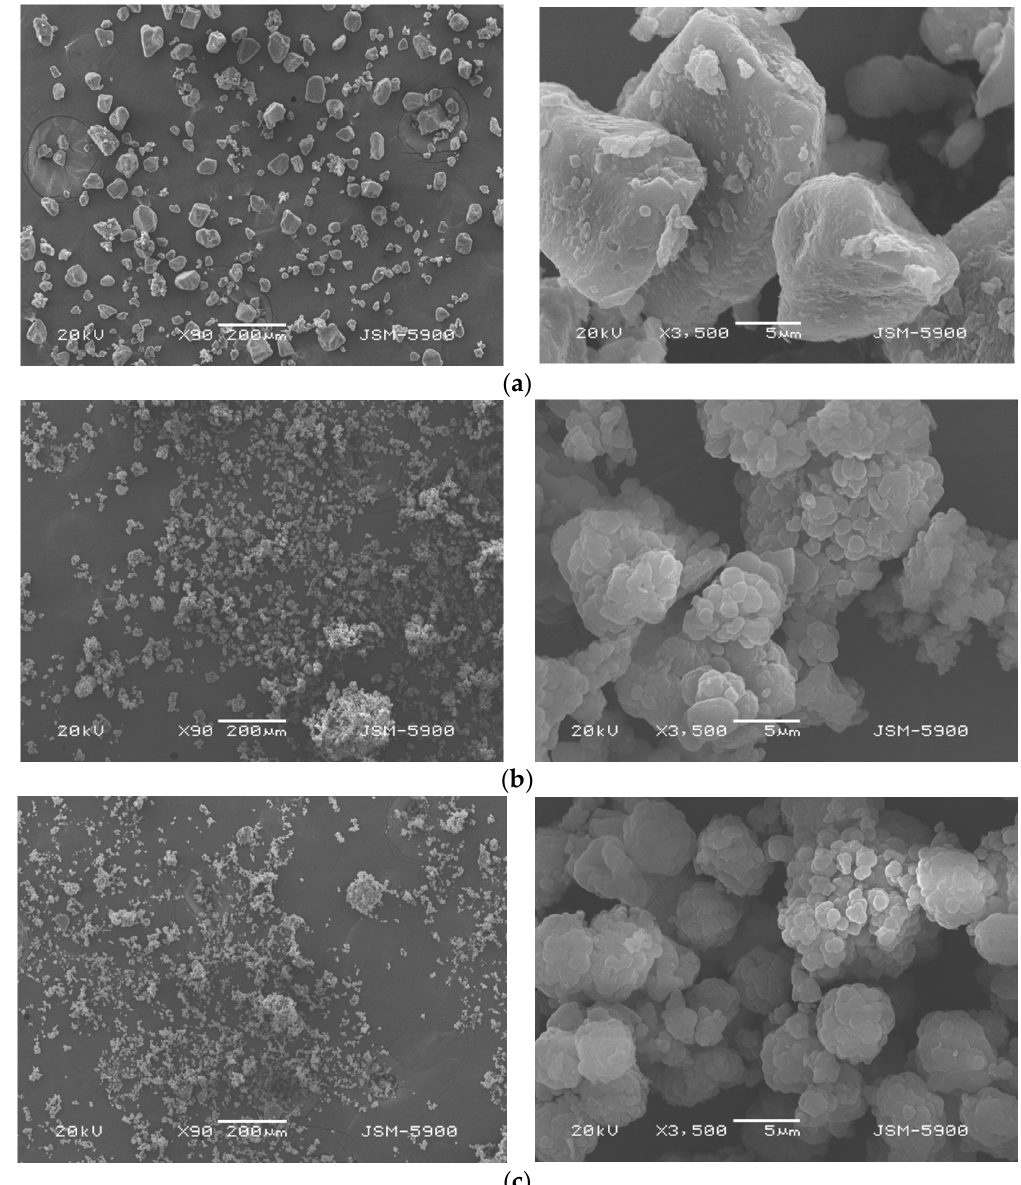
Figure 12. SEM images for hydrogel samples synthesized by RAFT copolymerization: ( a ) G315 (with Krytox); ( b ) G316 (without Krytox); and ( c ) G317 (with Krytox).